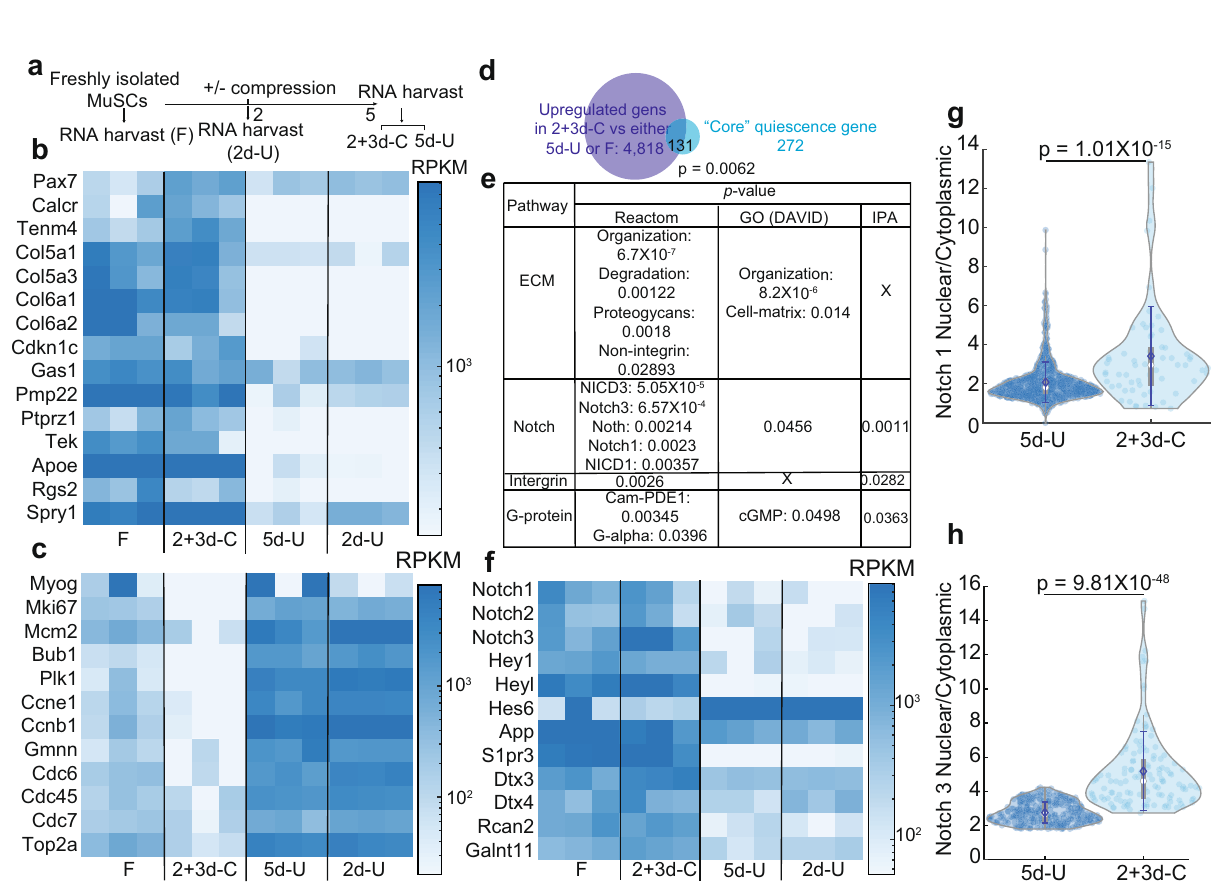
Fig. 3 Transcriptome comparison between 2 + 3d-C, 5d-U, and F cells. a Experimental setup. b , c , f Reads Per Kilobase of transcript, per Million mapped (RPKM) readings of MuSCs ’ quiescence and stemness ( b ), activation and differentiation ( c ), and Notch downstream genes ( f ). d Comparison between upregulated genes in 2 + 3d-C cells and “ core ” quiescence genes. e Pathway analyses on overlapped “ core ” quiescence genes. g and h Notch1 ( g ) and 3 ( h ) nuclear/cytoplasmic ratio comparison between 5d-U and 2 + 3d-C ( n = 3 for each experimental set in RNA-seq; ( g ) n = 4 for 5d-U ( + DMSO), of total 695 cells. n = 4 for 2 + 3d-C ( + DMSO), of total 61 cells. h n = 5 for 5d-U ( + DMSO), of total 291 cells. n = 3 for 2 + 3d-C ( + DMSO), of total 124